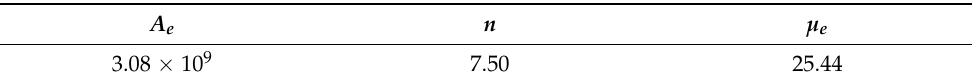
Figure 14. Evolution of the optimization process. The values obtained for nodes near the RVE top surface present some dispersion due to their proximity to the extreme boundary condition applied. Therefore, these three nodes have been removed from the results. Figure 15 shows the relationship between the nodes' location and the cooling rates reached in them and between the nodes' location and the lamellar spacing predicted.